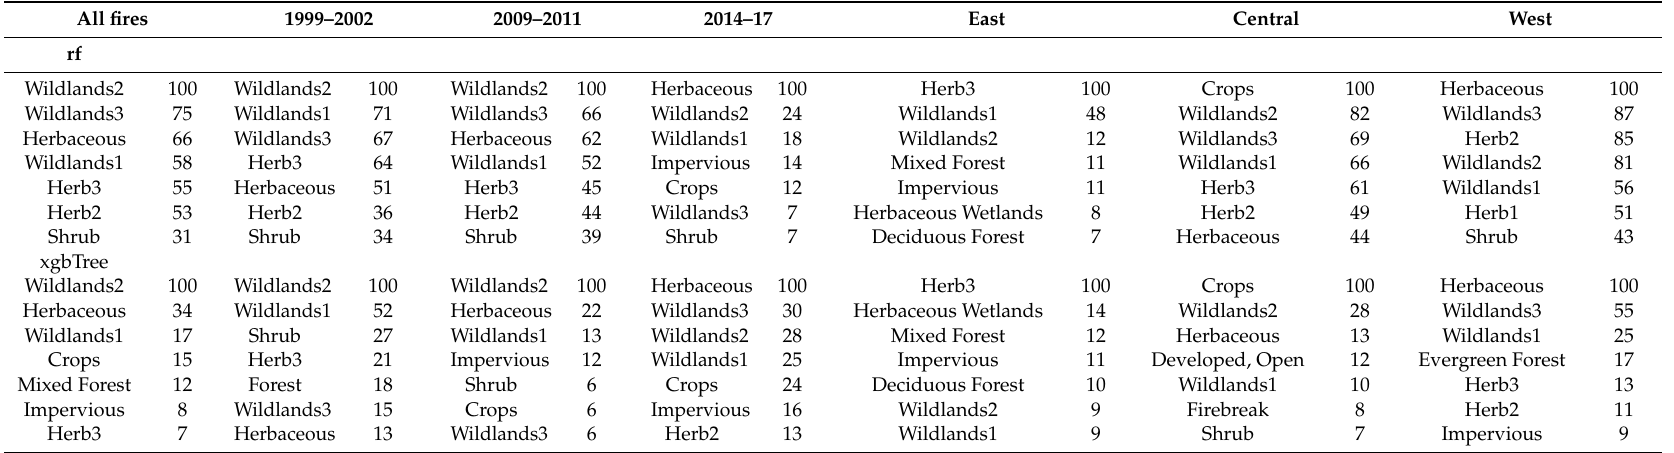
Table 6. Most important variables and value for random forests (rf) and extreme gradient boosting (xgbTree) models for all fires and by year and region (Wildlands1 = Forest + Grass + Shrub + Wetlands; Wildlands2 = Forest + Grass + Wetlands; Wildlands3 = Forest + Grass; Herb3 = Pasture + Crops + Developed, Open; and Herb2 = Grass + Pasture). All fires